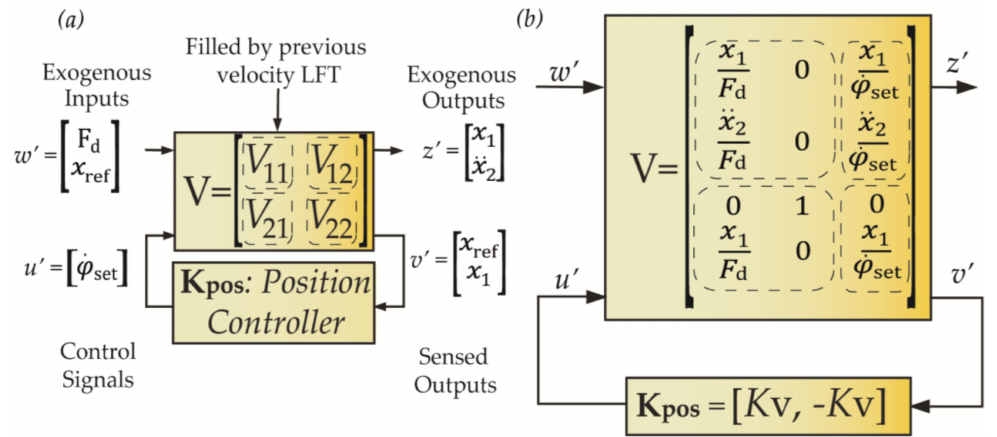
Figure 3. ( a ) Position controller LFT definition, ( b ) Matrix frequency domain relationship